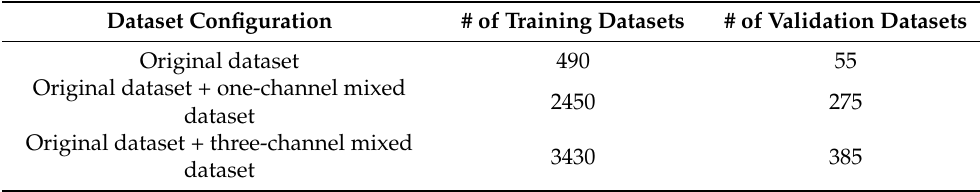
Table 4. Number of datasets after the augmentation, brake pad dataset.